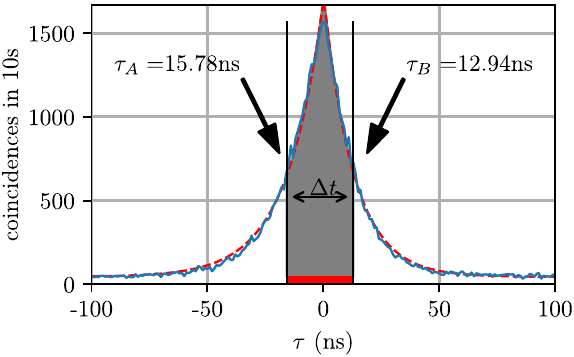
Fig. 2 Photon wave packet. Measured signal-idler coincidence function with a bin size of 1 ns. The red dashed line is a double exponential fi t to the data.